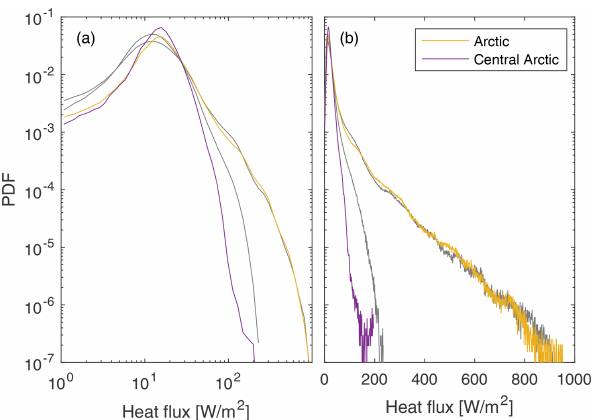
Figure 6. The probability density functions of modelled atmo- spheric heat flux in the Arctic and Central Arctic regions over JFM, using the viscous (coloured lines) and MEB (grey lines) rheological models.